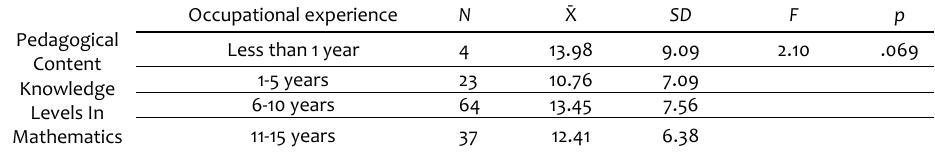
Table 4. Distribution of teachers’ pedagogical content knowledge levels in mathematics by occupational